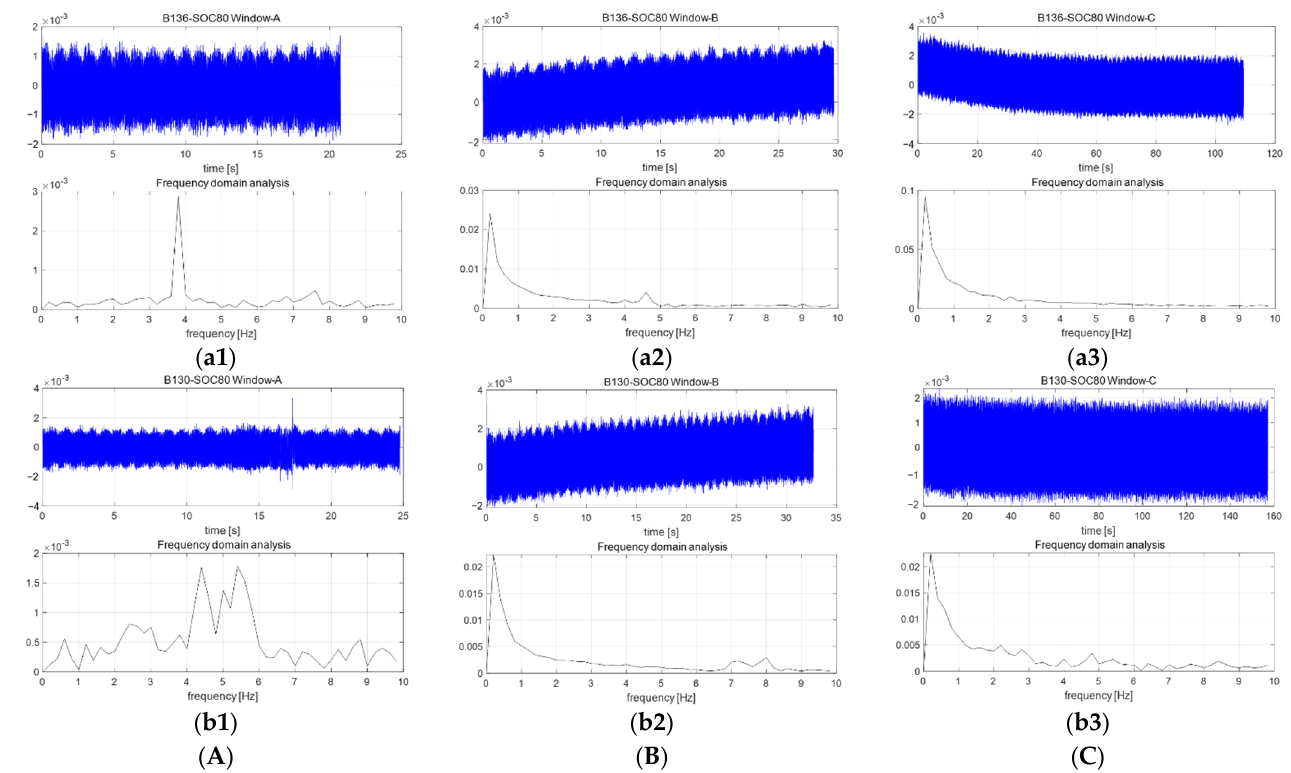
Figure 10. Two cases frequency domain characteristics of window A–C with initial SOC80 condi- tion. ( A ), acoustic signal before the ESC in ( a1 , b1 ); ( B ), acoustic signal during the ESC in ( a2 , b2 ); ( C ), acoustic signal near-end after the ESC in ( a3 , b3 ).